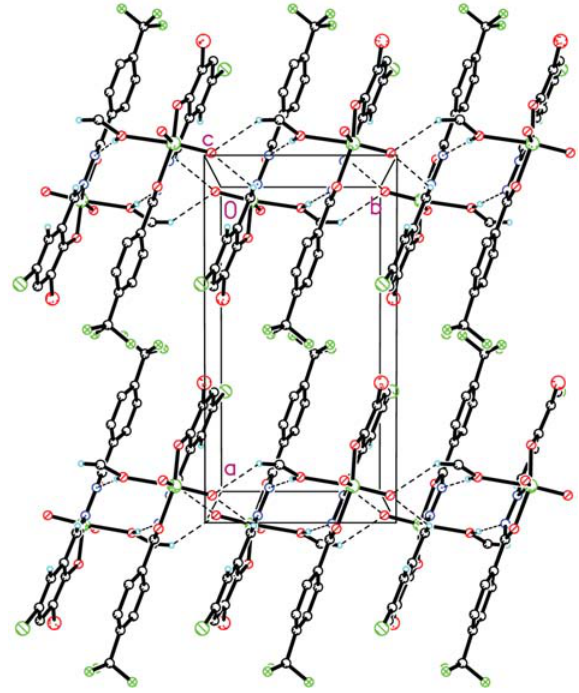
Figure 1. ORTEP plots (30% probability level) and numbering scheme for 1 . Figure 4. Hydrogen bond (dashed lines) linked structure of 2 , vie-